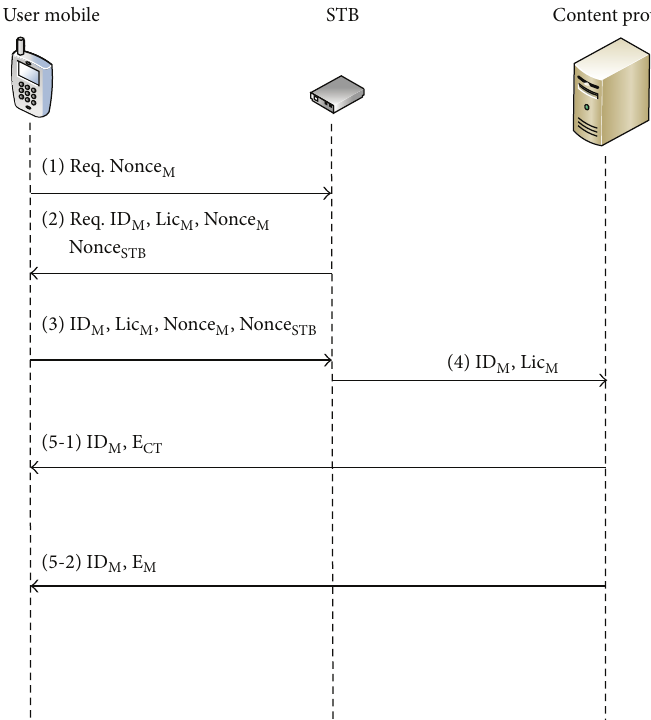
Figure 5: Migrating mobile devices to STB through access point at user